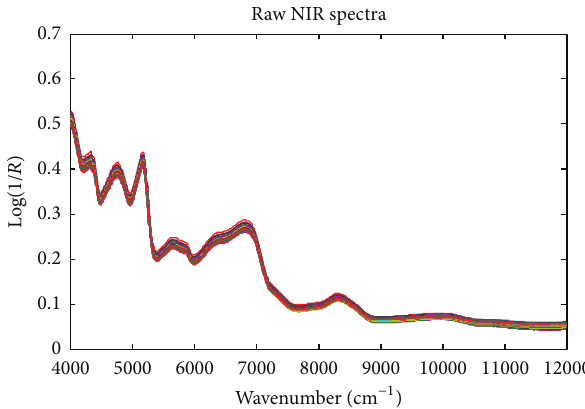
Figure 1: The raw NIR spectra of 120 adulterated oat flour objects with doping levels ranging from 5% to 50%